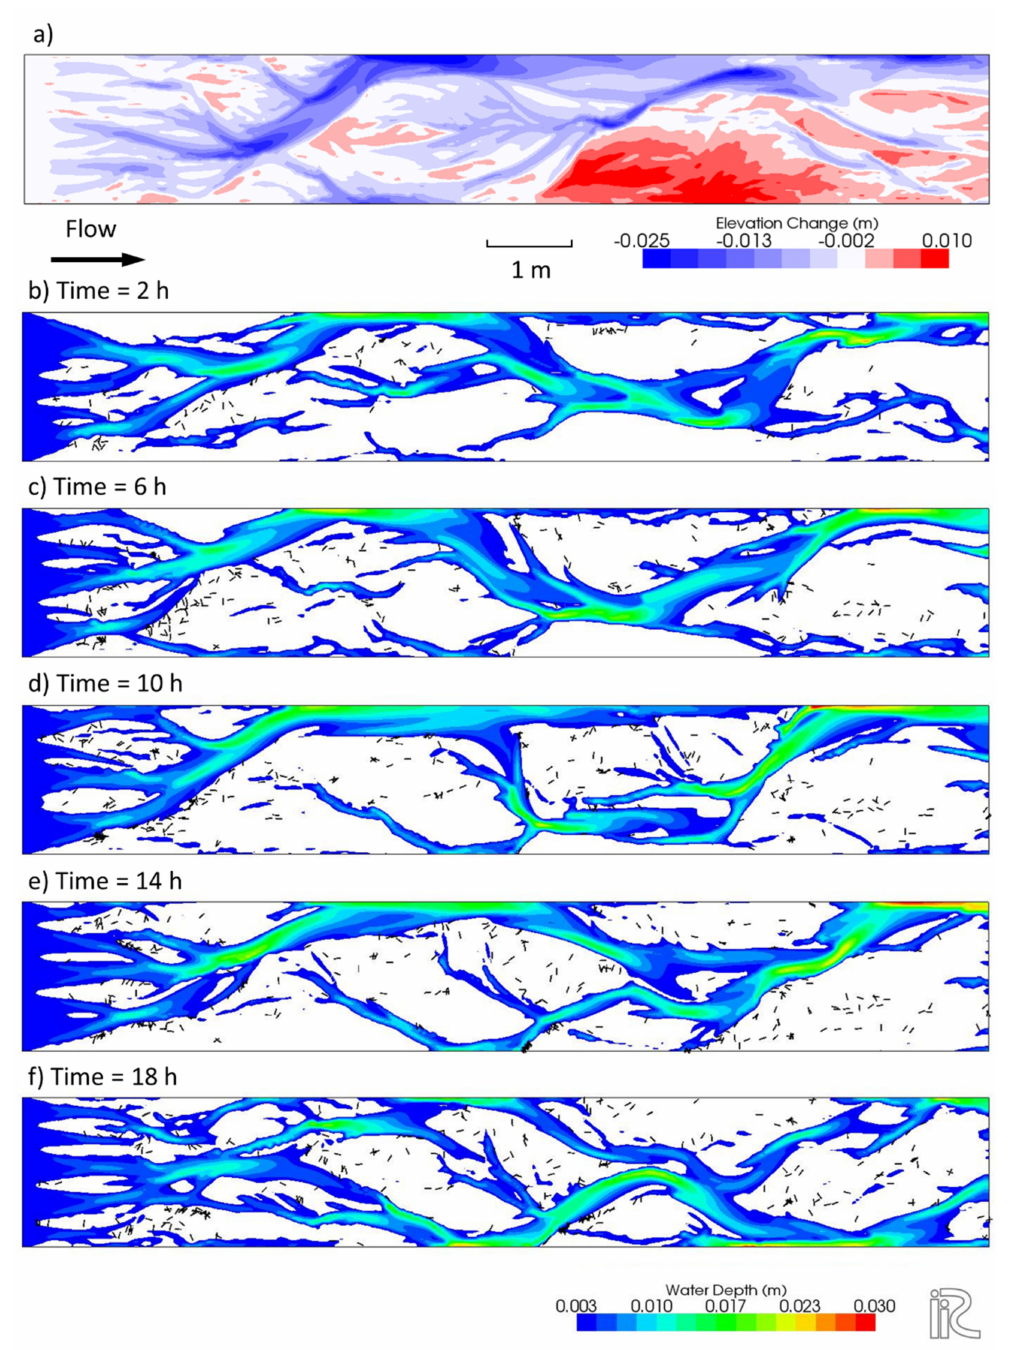
Figure 3. Numerical simulation of braided channel pattern and depositional pattern of wood pieces for Case C1 of Bertoldi et al. [16]. ( a ) bar and channel patterns by first 20 h obtained through morphodynamic calculation; ( b – f ) temporal changes during the latter 18 h calculated for channel, and depositional patterns of wood piece. Solid-black lines denote wood pieces. The diameter of wood pieces is increased by factor of 5 for